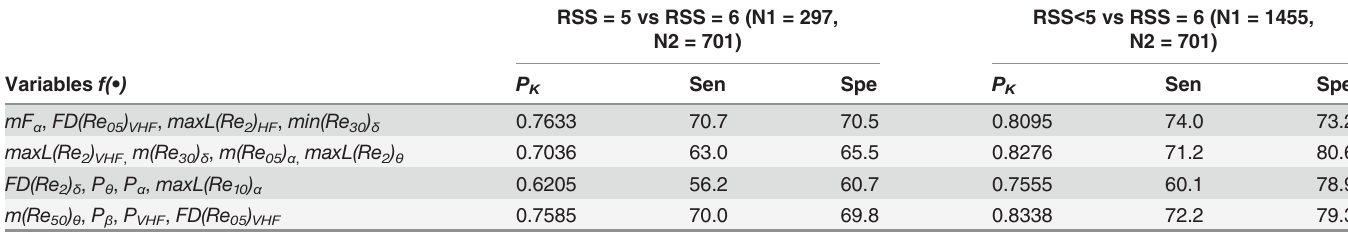
Table 3. RSS assessment: trial 1 and